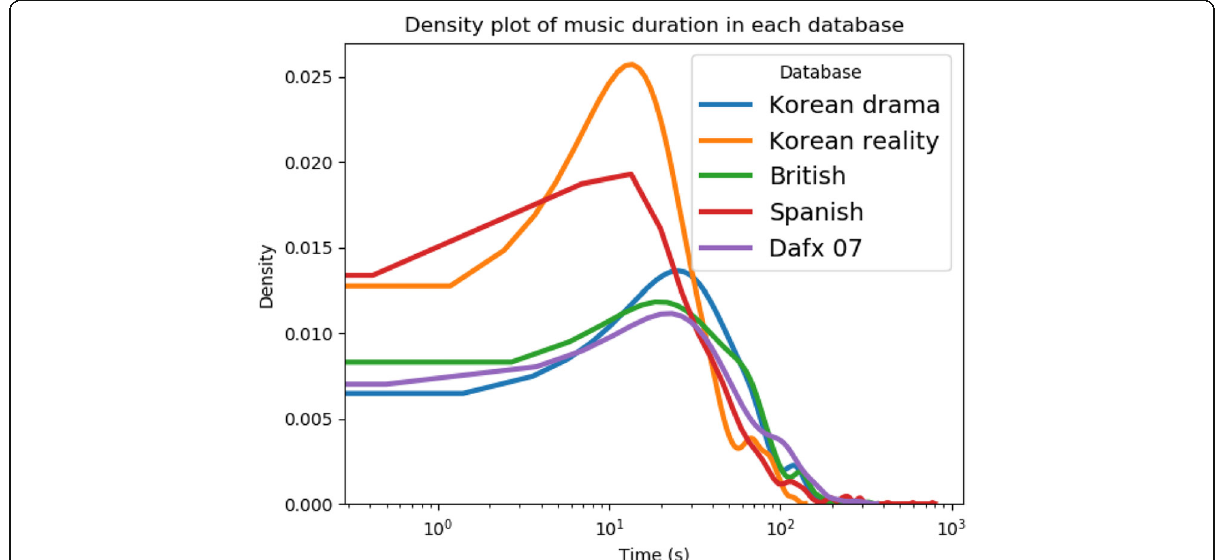
Fig. 8 Density of music segment